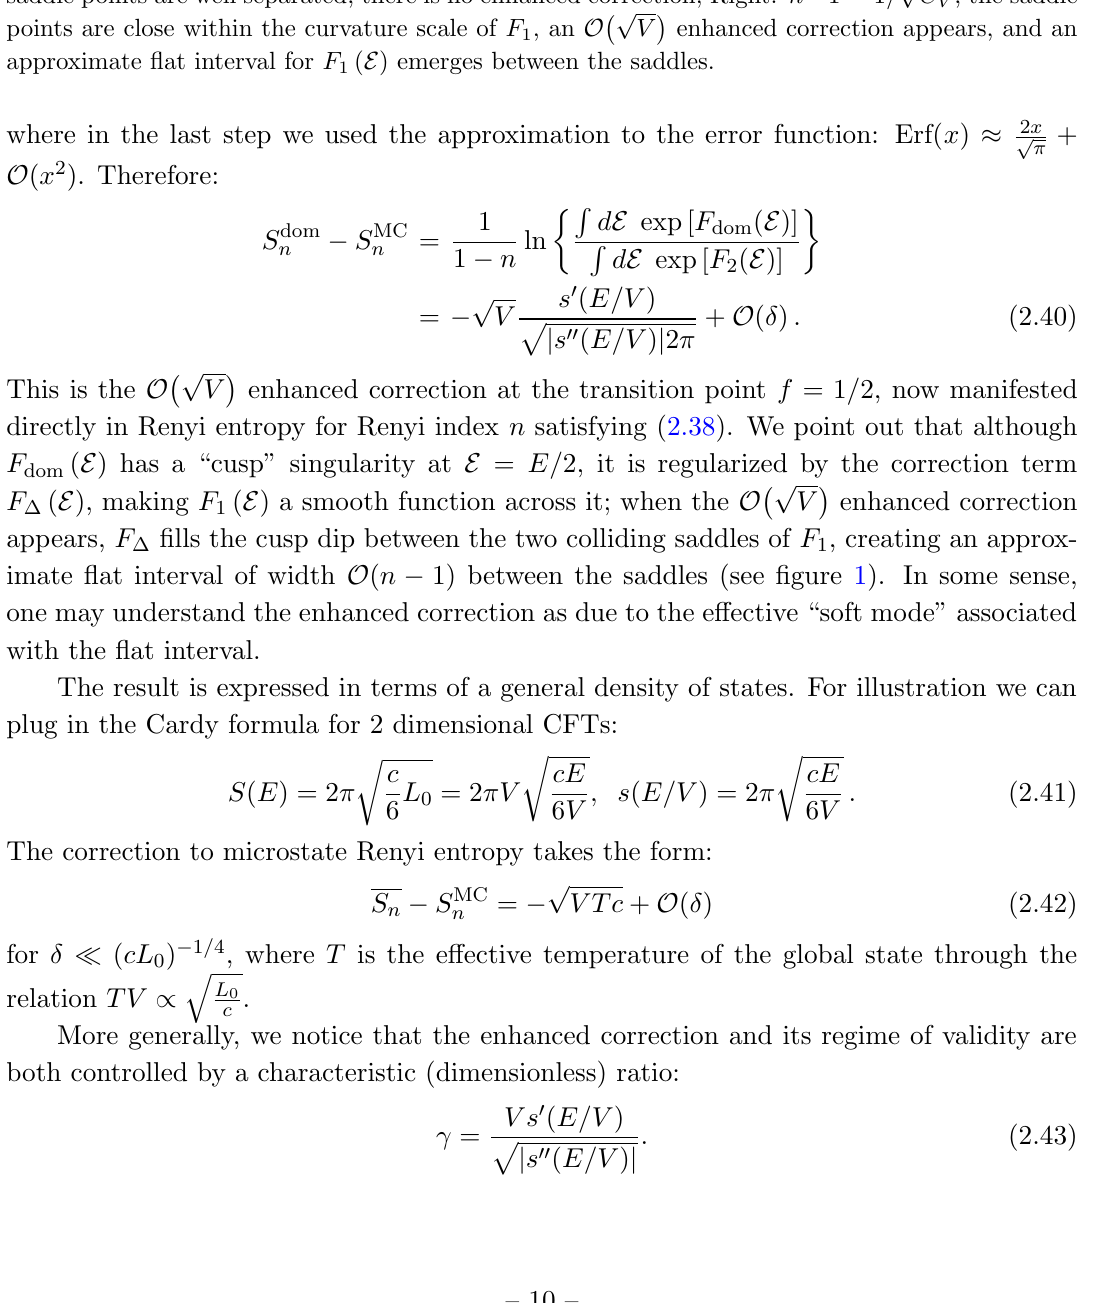
p C V , the p C V , the saddle p (cid:0) (cid:1) V enhanced correction appears, and an